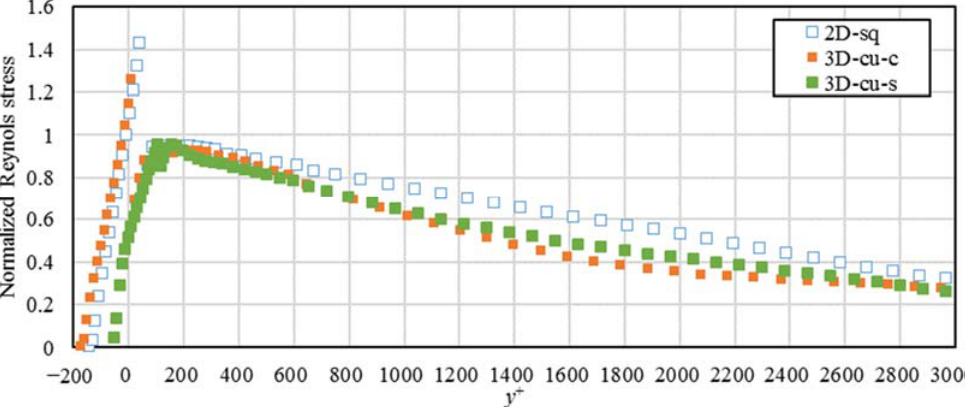
Figure 8. Normalized Reynolds stress profiles averaged over roughness elements.